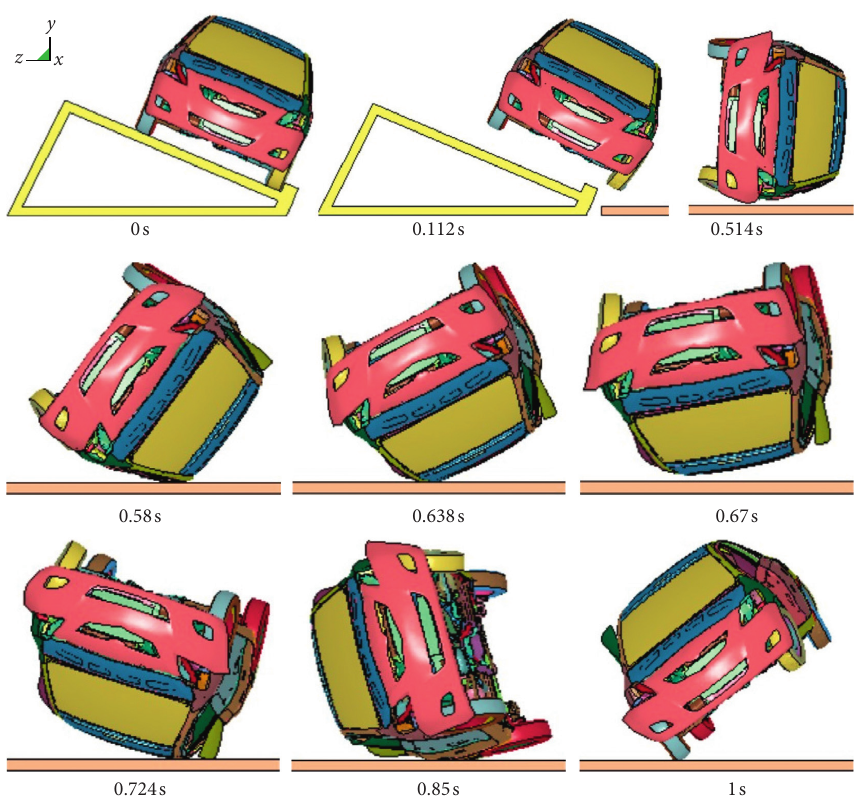
Figure 3: Sequence of images of the rollover analysis of the Toyota Yaris sedan